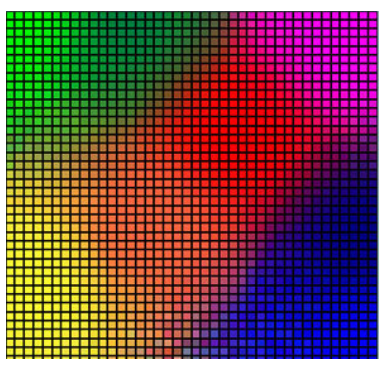
Figure 1. Visualization Property of SOM